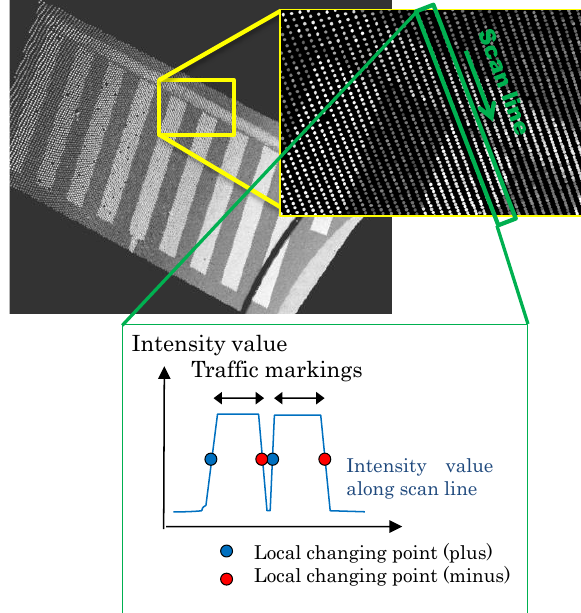
Figure8. Local changing point detection along scan lines from LiDAR